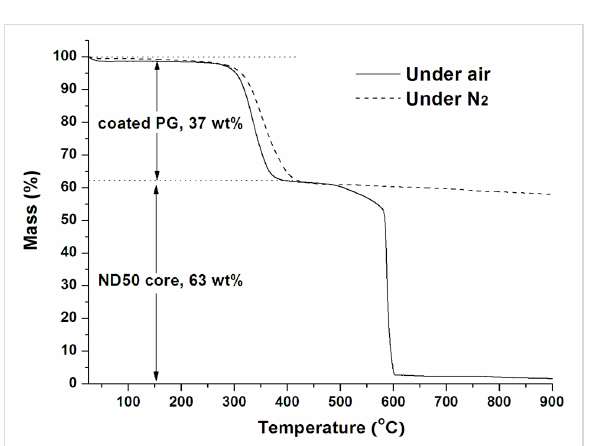
Figure 3: TGA profiles of ND50-PG under nitrogen and air.